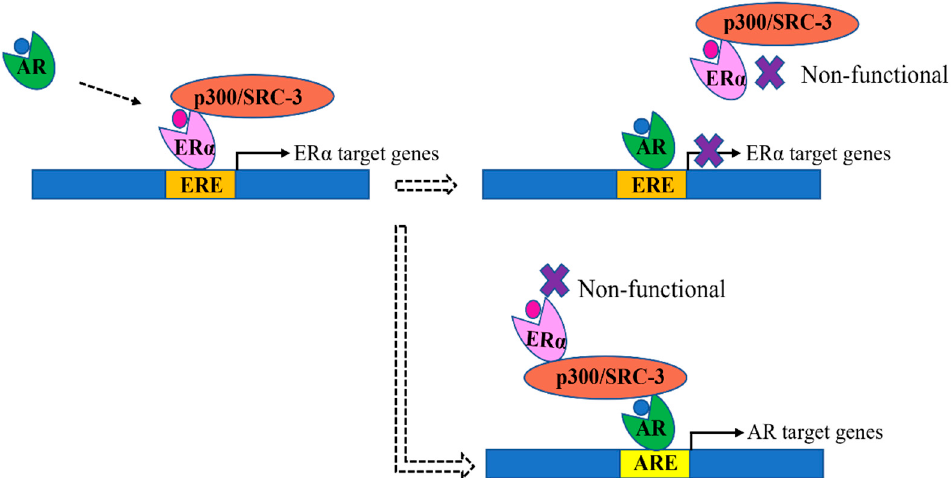
Figure 1. The proposed mechanism for the suppression of AR on ER α as reported by Hickey et al. [19]. Under normal circumstances, active ER α interacts with its coactivators, such as p300/SRC-3, and then bind to estrogen response element (ERE) to induce the transcription. Active AR may act as an ER α suppressor by competitive binding to ERE or by interacting with ER α coactivators to hijack ER α from ERE to ARE, thereby preventing ER α from transcribing its target genes.